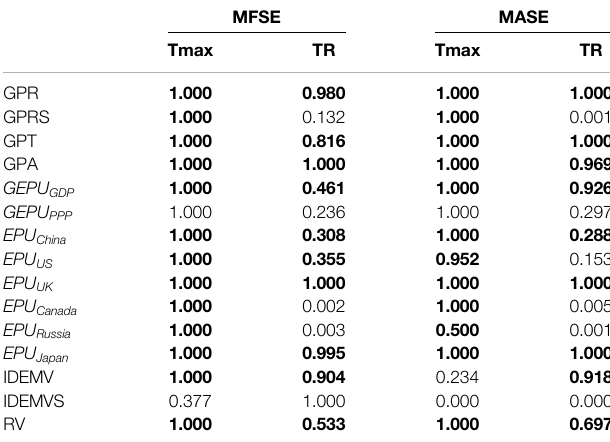
TABLE 7 | MCS test with quarterly